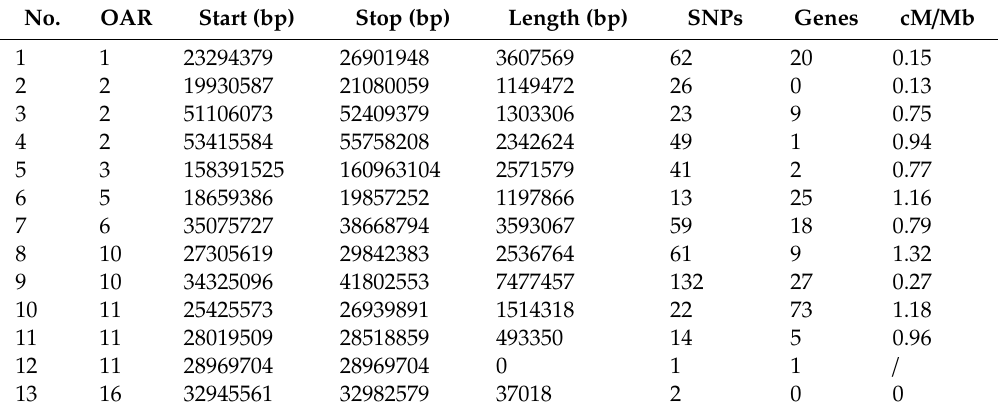
Table 2. ROH hotspots detected in Chinese Merino and average recombination rate (cM / Mb) within each hotspot.